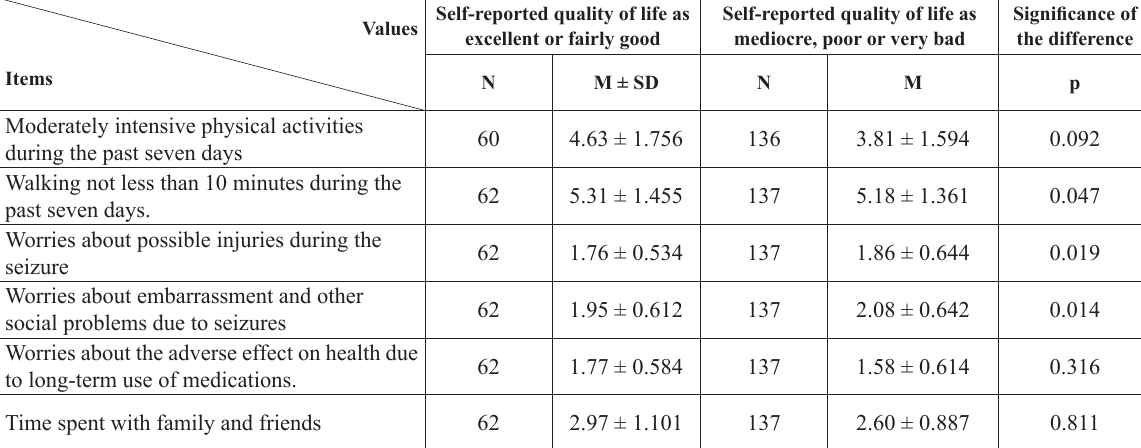
Table 3. Interrelations of self-reported quality of life, psychosocial problems and physical activity in patients with epilepsy